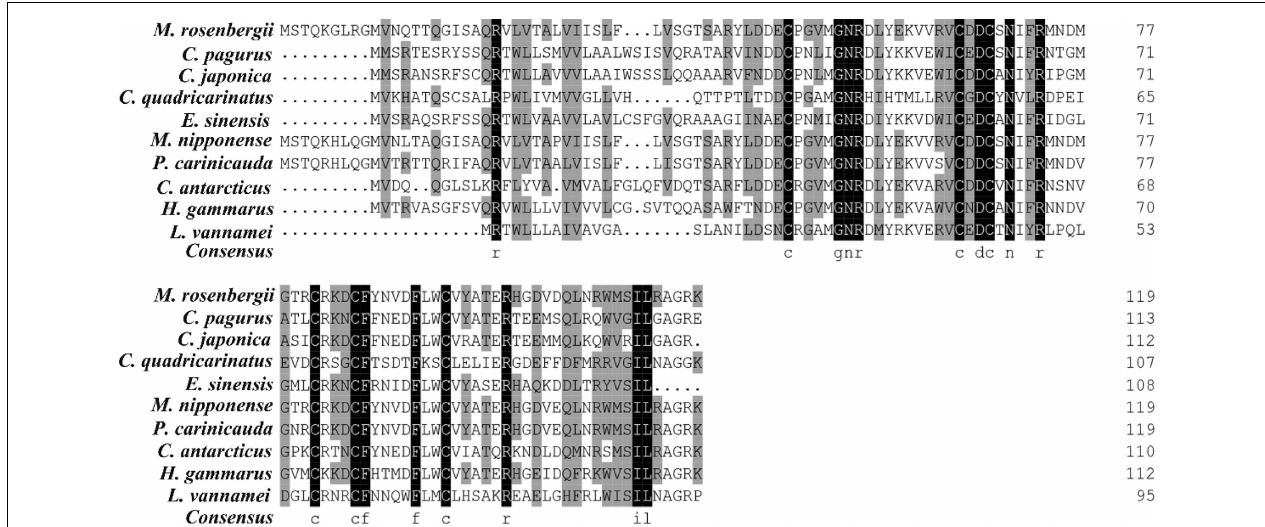
FIGURE 2 | Multiple-sequence alignments of Mr GIH with other crustaceans. Species of Cancer pagurus (CAB61424.1) , Charybdis japonica (ACD11361.1) , Cherax quadricarinatus (AWK57516.1) , Eriocheir sinensis (AAQ81640.1) , Macrobrachium nipponense (AEJ54622.1) , Palaemon carinicauda (AIJ49750.1) , Chorismus antarcticus (ANQ38670.1) , Homarus gammarus (ABA42181.1), Litopenaeus vannamei (KF879913.1) were aligned. Highly conserved amino acids were represented by black background.